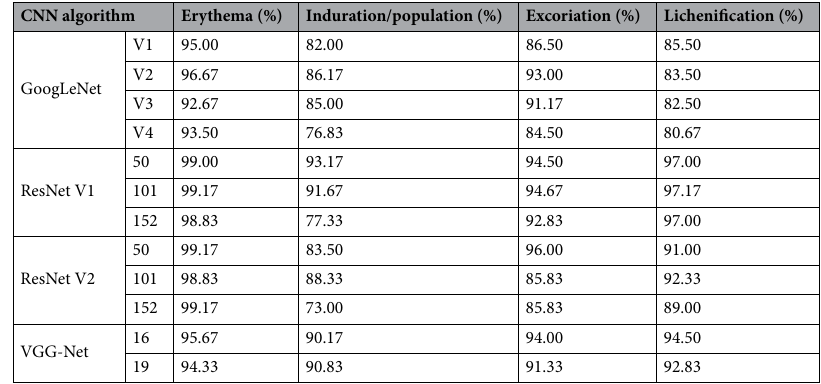
Table 1. Scoring accuracy of erythema, induration/papulation, excoriation, and lichenification according to the CNN